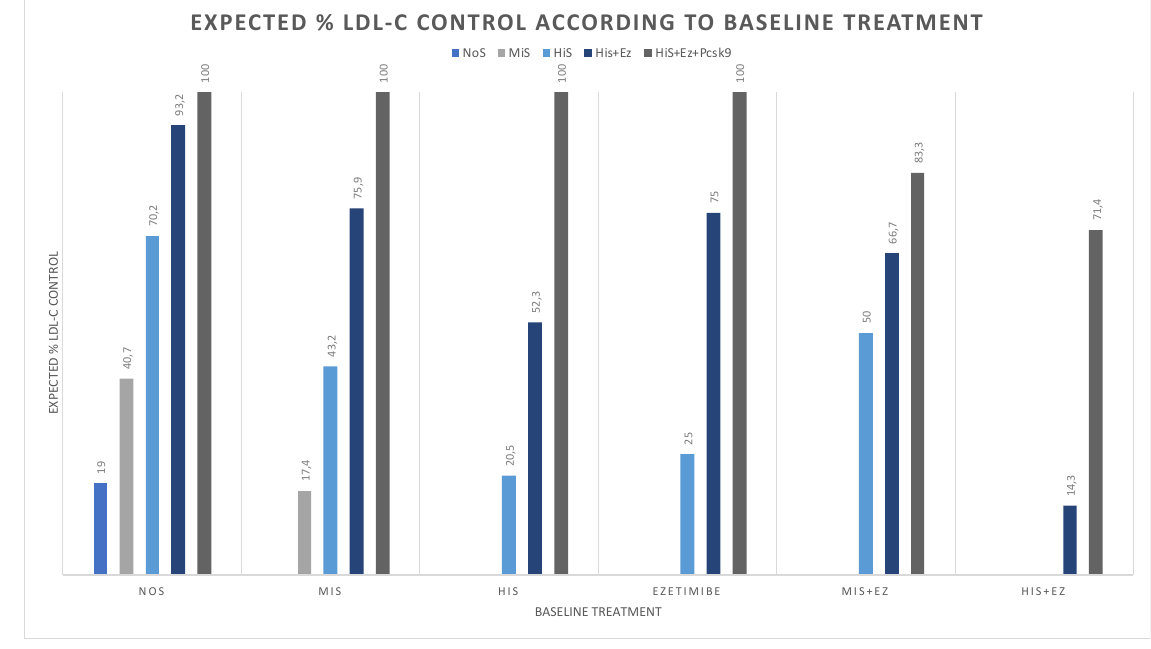
Figure 3. Baseline and expected relative change in LDL-C control rate according to current and escalated therapies. NOS, statin-naïve; MIS, moderate-intensity statin; HIS, high-intensity statin; MIS + Ez, MiS combined with ezetimibe; HiS + Ez, HIS combined with ezetimibe; HbA1c, glycated hemoglobin.